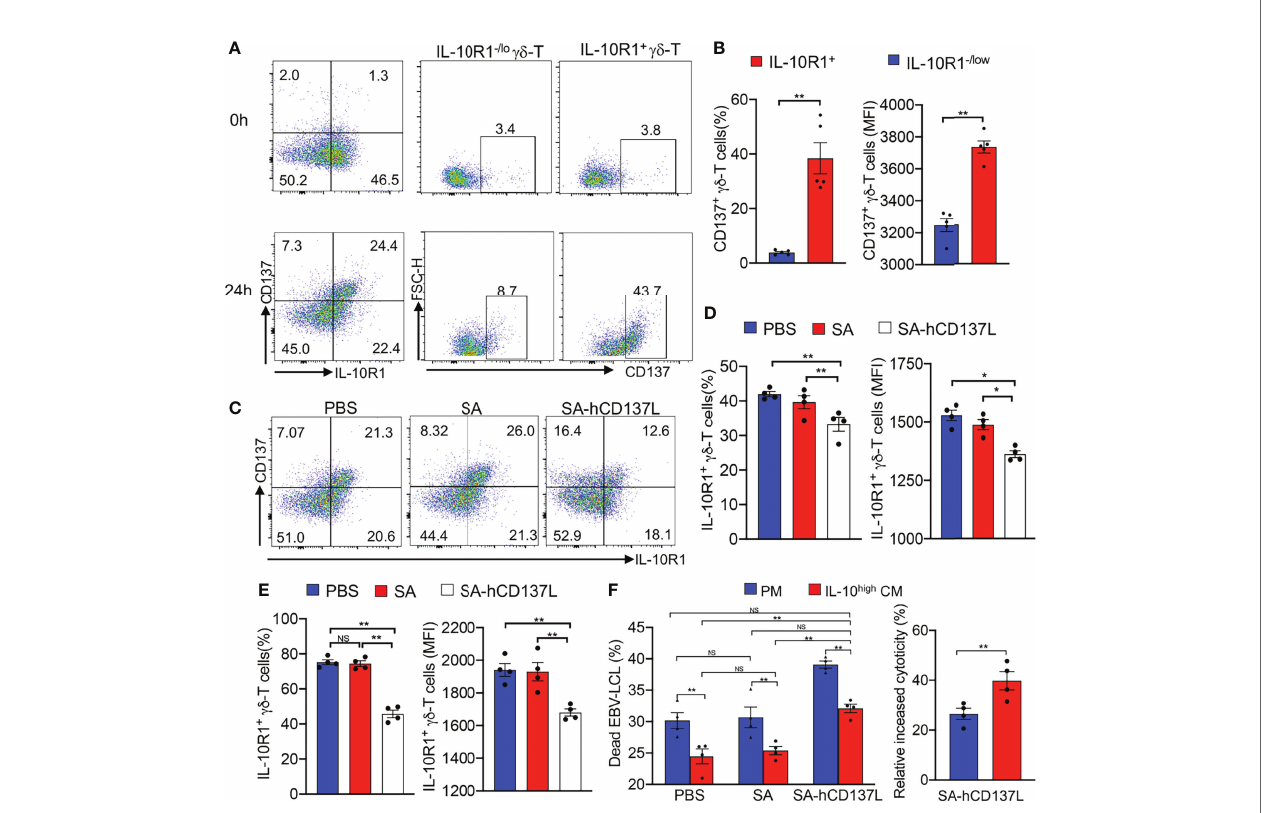
FIGURE 3 | CD137 costimulation suppressed IL-10R1 expression and restored the antitumor activity of V g 9V d 2-T cells. (A) The expression of CD137 on IL-10R1 -/lo and IL-10R1 + V g 9V d 2-T cells before (0h) and after stimulation with anti- gd -TCR mAb for 24h (24h) in IL-10 high CM. (B) The percentages and expression levels (mean fl uorescence intensities, MFI) of CD137 on IL-10R1 -/lo and IL-10R1 + V g 9V d 2-T cells upon stimulation for 24h in IL-10 high CM. (C, E) The FACS patterns of CD137 and IL-10R1 expressions (C) , surface expression of IL-10R1 in total V g 9V d 2-T cells (D) and in CD137 + V g 9V d 2-T cells (E) upon stimulation by anti- gd -TCR mAb supplemented with SA-CD137L (500ng/ml), PBS and SA in IL-10 high CM for 24h were detected by fl ow cytometry after surface staining of IL-10R1. (F) Puri fi ed V g 9V d 2-T cells were pretreated with SA-hCD137L (500ng/ml), PBS or SA for 24 h in the PM and IL-10 high CM, and then cocultured with autologous EBV-LCL at an E: T ratio of 10:1 for 4-6h. The proportions of dead EBV-LCL (CD3 - PI + , left), and the relative increase of cytotoxicity after being treated with SA-hCD137L (right) are shown. All data are shown as mean ± SEM and representative of three independent experiments. *p < 0.05; **p < 0.01; ns, no signi fi cant